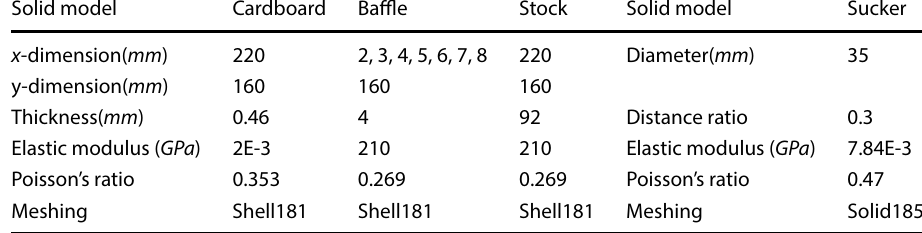
Table 1 Property